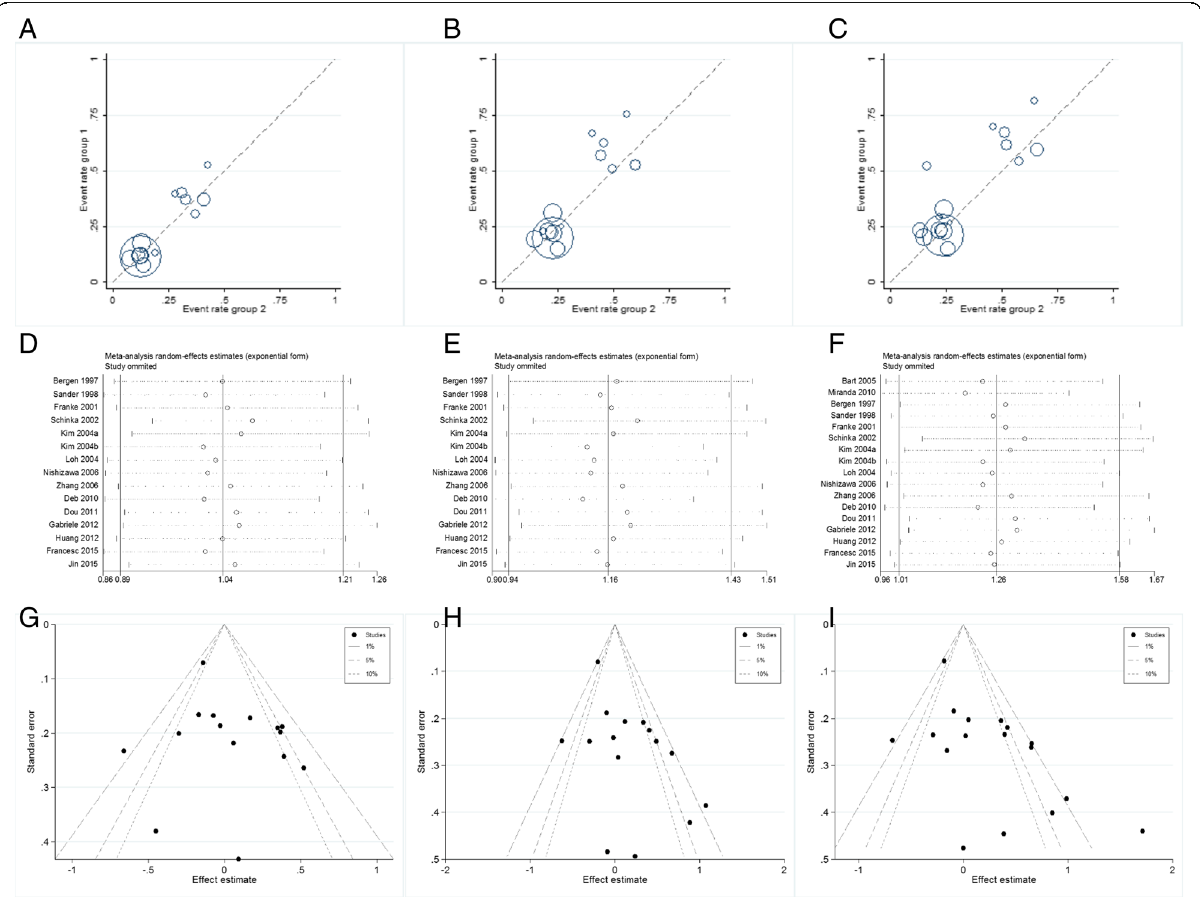
Fig. 2 Labbe plots, sensitivity analysis plots, and contour-enhanced funnel plots of the included studies focusing on the association of the OPRM1 A118G polymorphism with alcohol dependence risk. Labbe plots in allele model ( a ), heterozygote model ( b ), and dominant model ( c ). Sensitivity analysis in allele model ( d ), heterozygote model ( e ), and dominant model ( f ). Contour-enhanced funnel plots in allele model ( g ), heterozygote model ( h ), and dominant model ( i